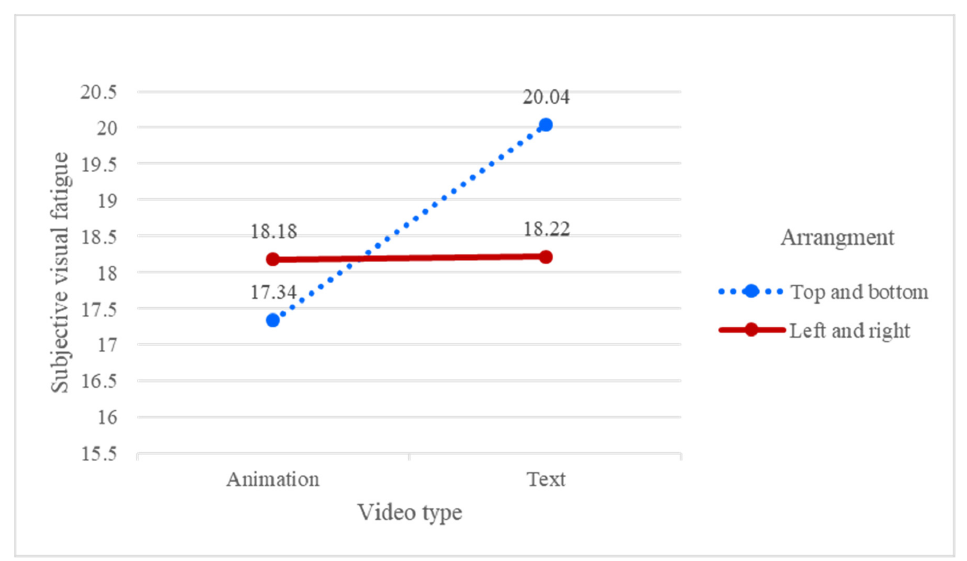
Figure 6. The interaction between display technique and ambient illumination for subjective visual fatigue.